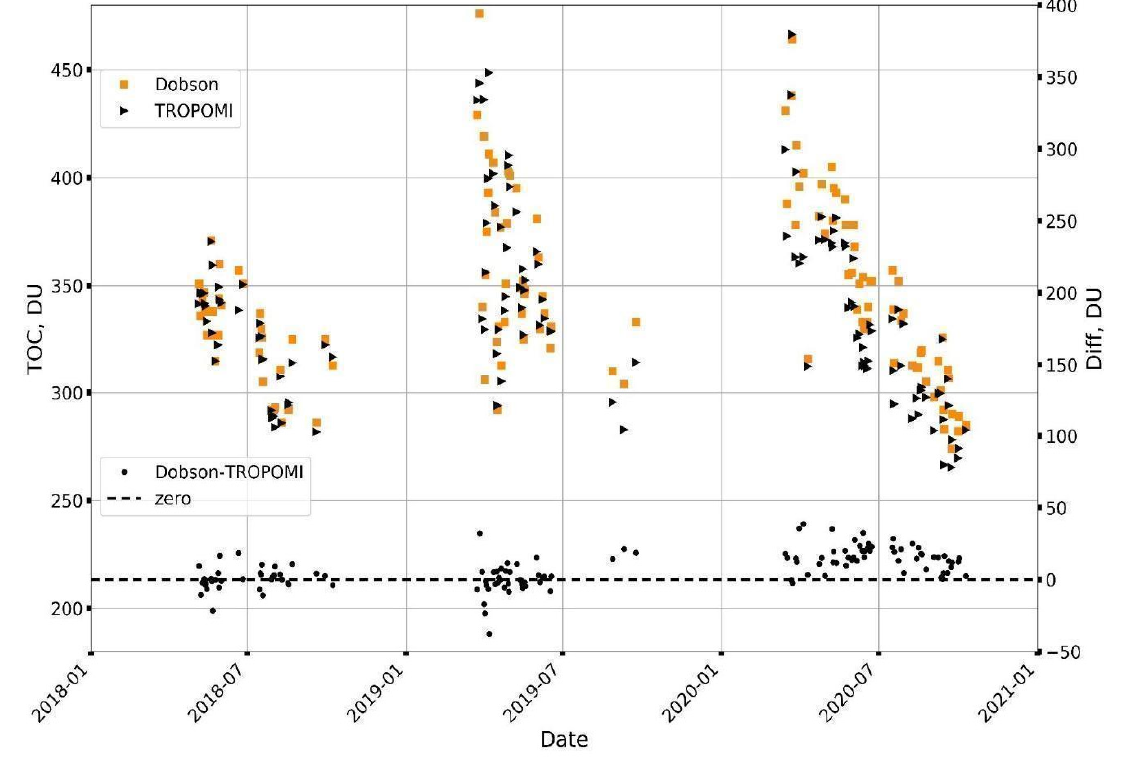
Figure 4. Time series of daily mean TOC near St. Petersburg in the 2018–2020 period according to the ground-based (Dobson) and satellite (TROPOMI) measurements (left scale) and their differences (right scale).